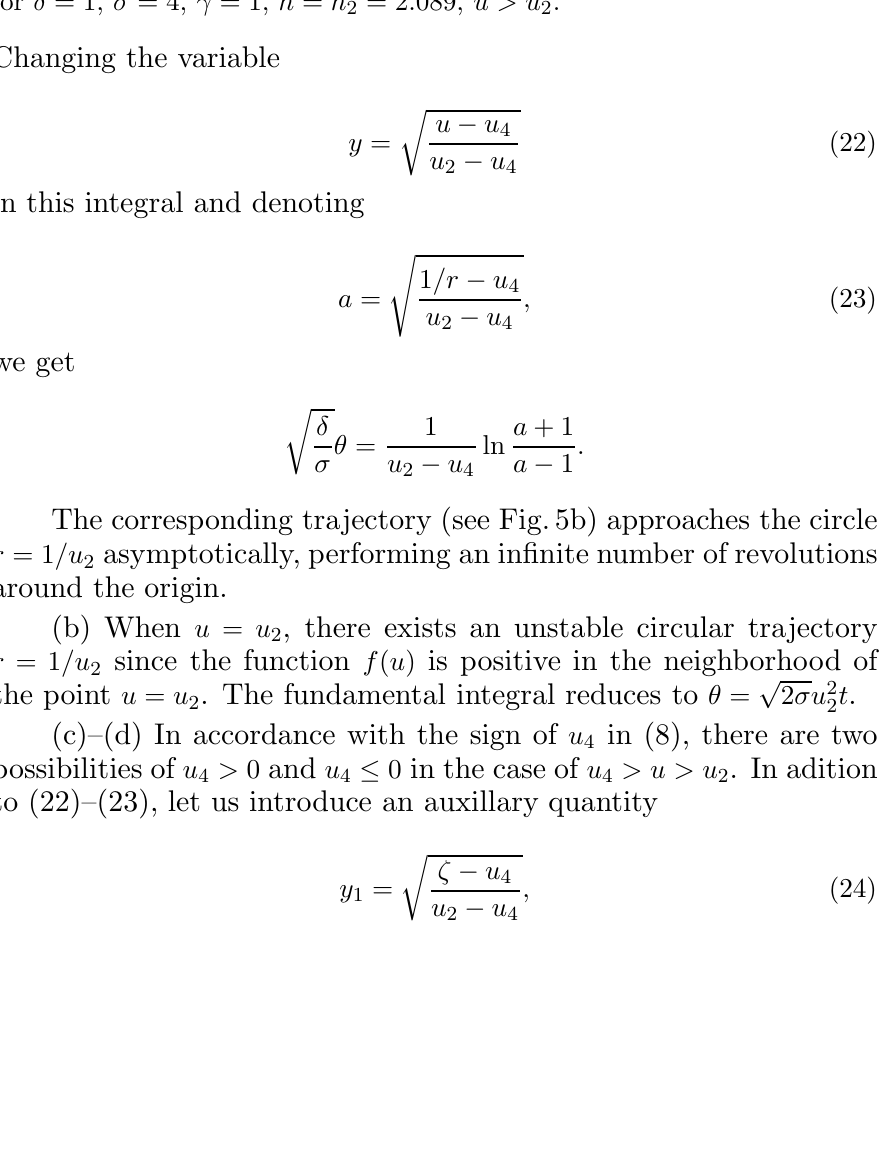
Fig. 5. The roots of the cubic f ( u ) for h = h 2 and corresponding trajectory for δ = 1, σ = 4, γ = 1, h = h 2 = 2 . 089, u > u 2